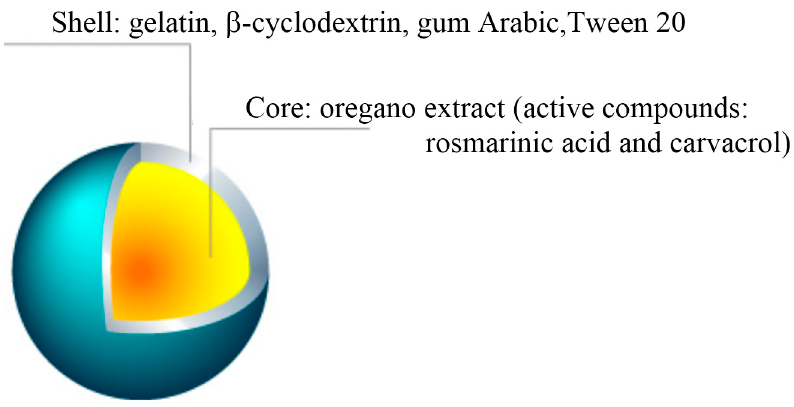
Figure 4. Microcapsule structure.